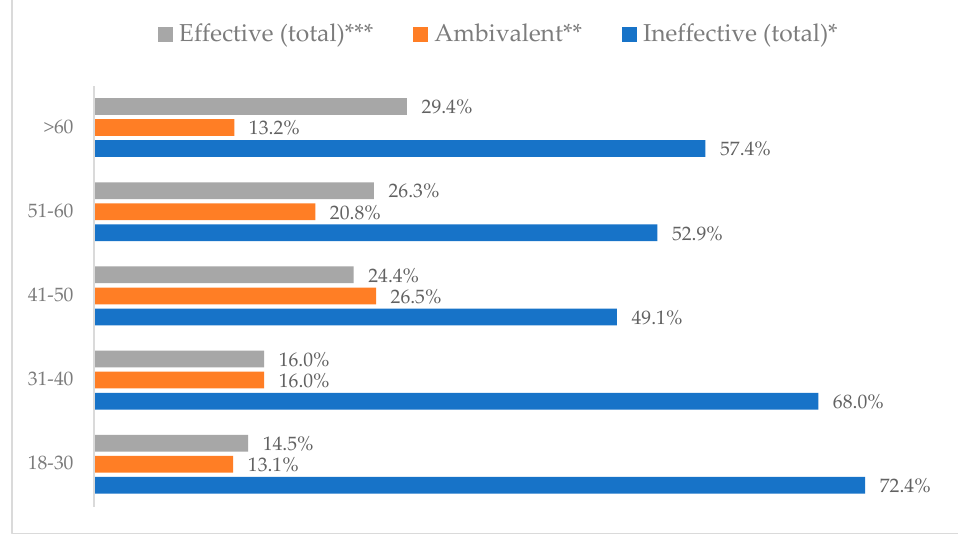
Figure 32 . Taking vitamin C daily to prevent influenza virus infection by age ( N = 905). *Sum of